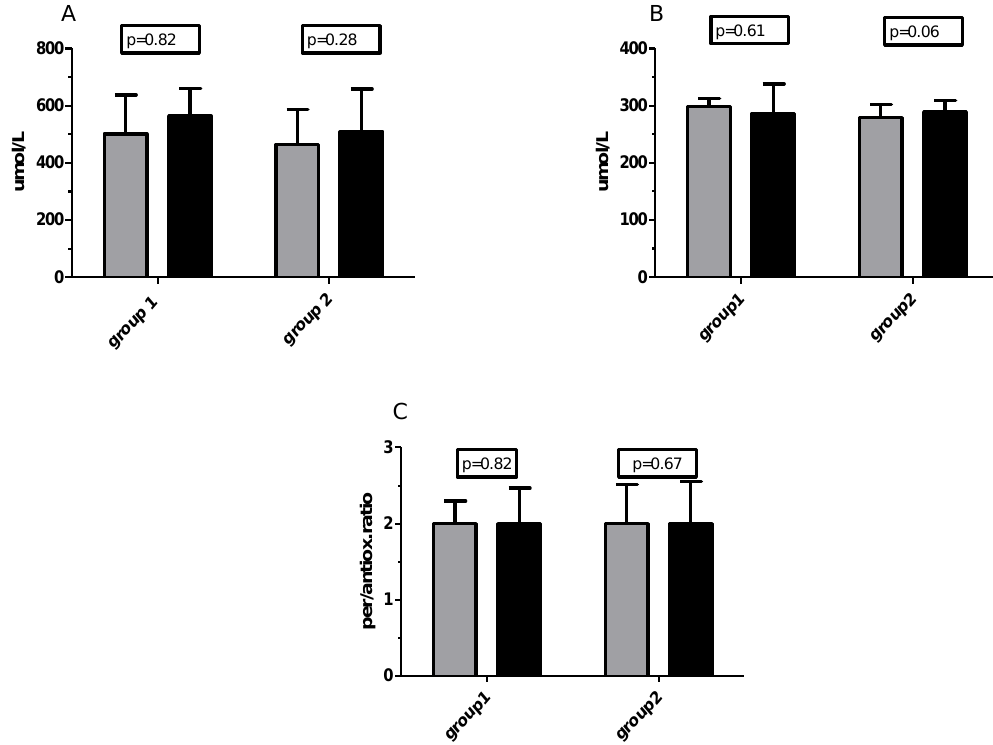
Figure 4. Changes in total oxidative status (TOS) / total oxidative capacity (TOC) ( A ), total antioxidative status (TAS) / total antioxidative capacity (TAC) ( B ), and prooxidative / antioxidative ratio ( C ) before (grey bars) and after 6 weeks of training (dark bars) supported by Vitamin C supplementation.